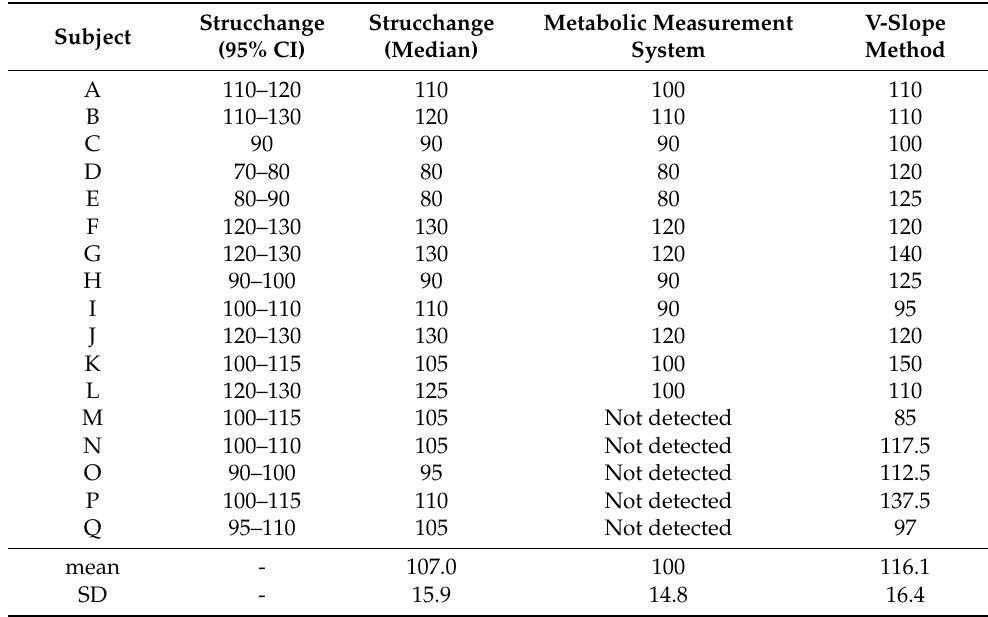
Table 3. AT by strucchange, V-slope methods, and respiratory metabolic analysis in VCO 2 (numbers in table converted to W).